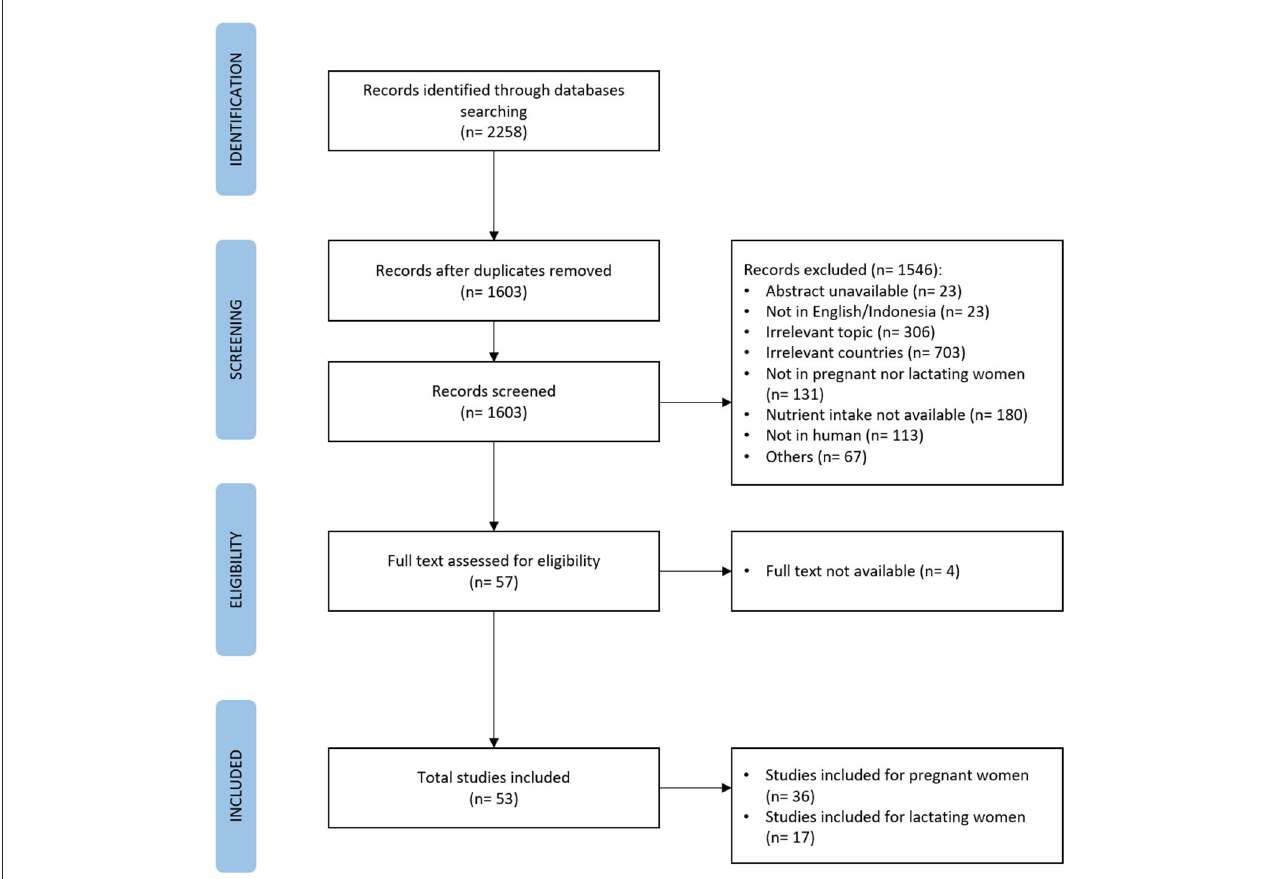
FIGURE1 Prisma flow diagram of systematic